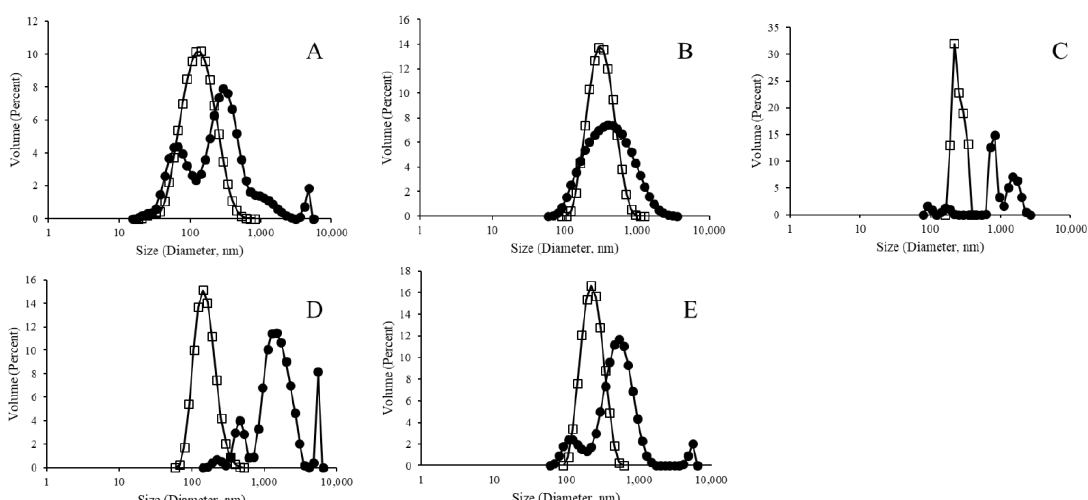
Figure 2. Size distribution analysis of empty liposomes, with closed circles representing pre-extrusion and open squares representing post-extrusion samples for liposomes without a metallic binding element (( A ) polydispersity index (PDI): 0.62 and 0.31), and with Ni (( B ) PDI: 0.32 and 0.25), Co (( C ) PDI: 0.42 and 0.74), Zn (( D ) PDI: 0.40 and 0.46), and biotinylation (( E ) PDI: 0.49 and 0.33).